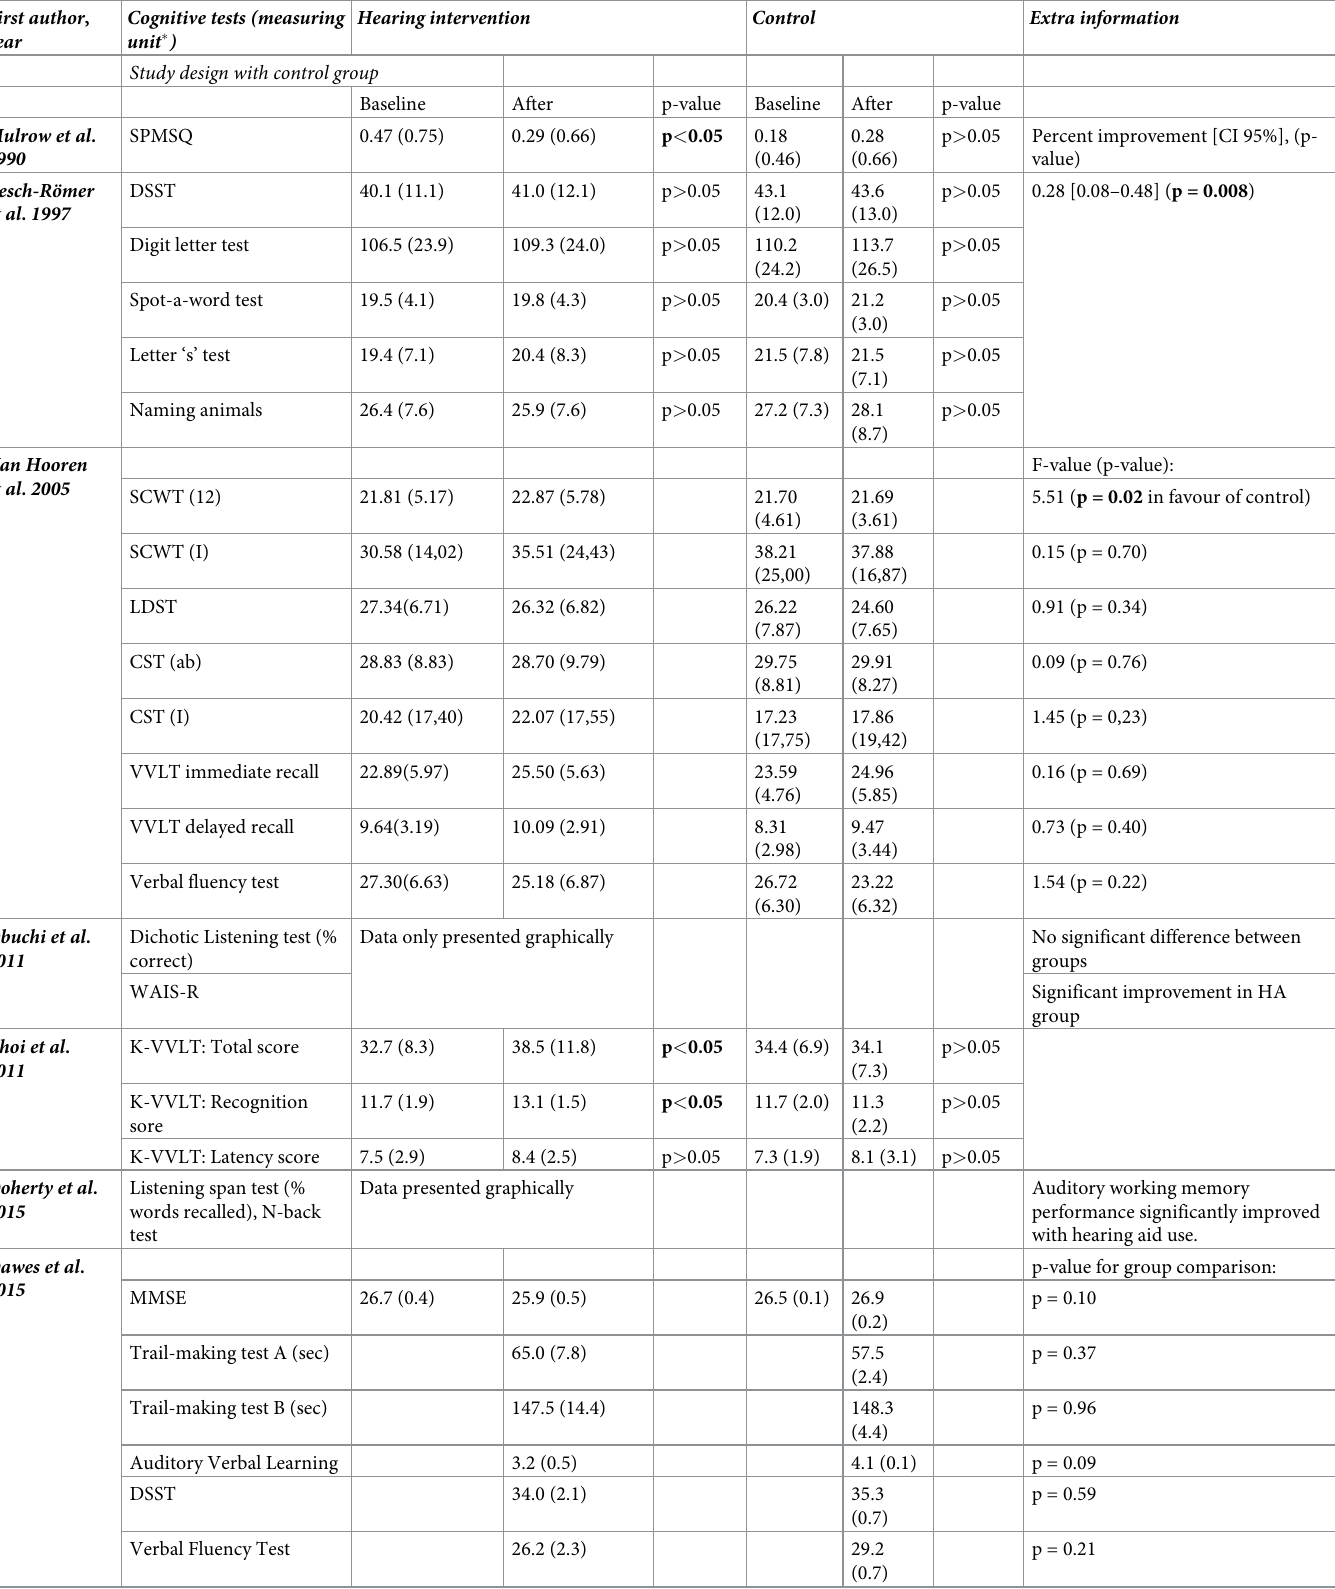
Table 4. Summary of cognitive